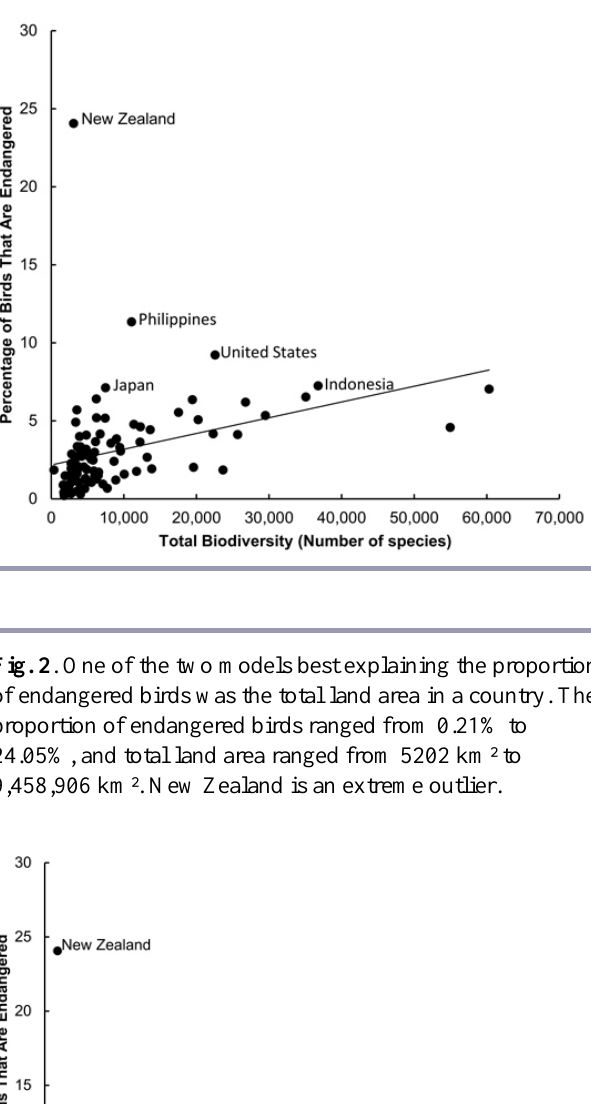
Fig. 3 . The model best explaining the proportion of invasive birds was the per capita GDP in a country. The proportion of invasive birds ranged from 0% to 11.73% and per capita GDP ranged from $630 to $38,165. New Zealand is an extreme outlier.